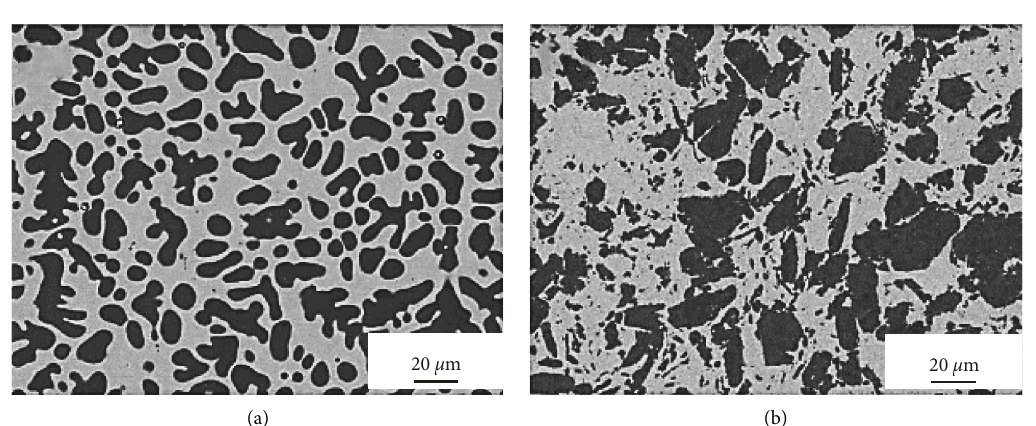
Figure 9: Microstructures of the Cu55Cr45 alloys. (a) Vacuum induction melting. (b) Mechanical alloying+ hot pressing sintering [19].